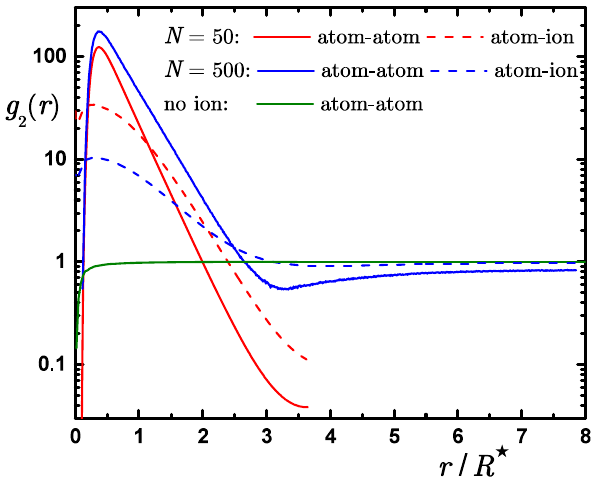
Fig. 4 Two-body correlation functions. Atom – atom (solid line) and atom – ion (dashed line) two-body correlation function g 2 ( r ) obtained from variational Monte Carlo calculation for N = 500 atoms (upper curves) and N = 50 atom (lower curves) for a ai = R ⋆ ; g 2 ( r ) in a weakly interacting Bose gas in absence of the ion is shown with a green line. The critical number of atoms N c which can be trapped by an ion is larger than the number of particles for N = 50, which explains the pronounced maximum observed in the red lines at distances of the order of the ion potential range, r ≈ R ⋆ . The data is shown up to the half-size of the simulation box L /2 and as a result the data with N = 50 abruptly stops without yet reaching a plateau. Instead, for N = 500 particles, the number of atoms is larger than the critical number N c and the half-size of the simulation box L /2 is larger than the size of the many-body bound state. As a result the long-range plateau observed for N = 500 atoms signals presence of a homogeneous gas of atoms.